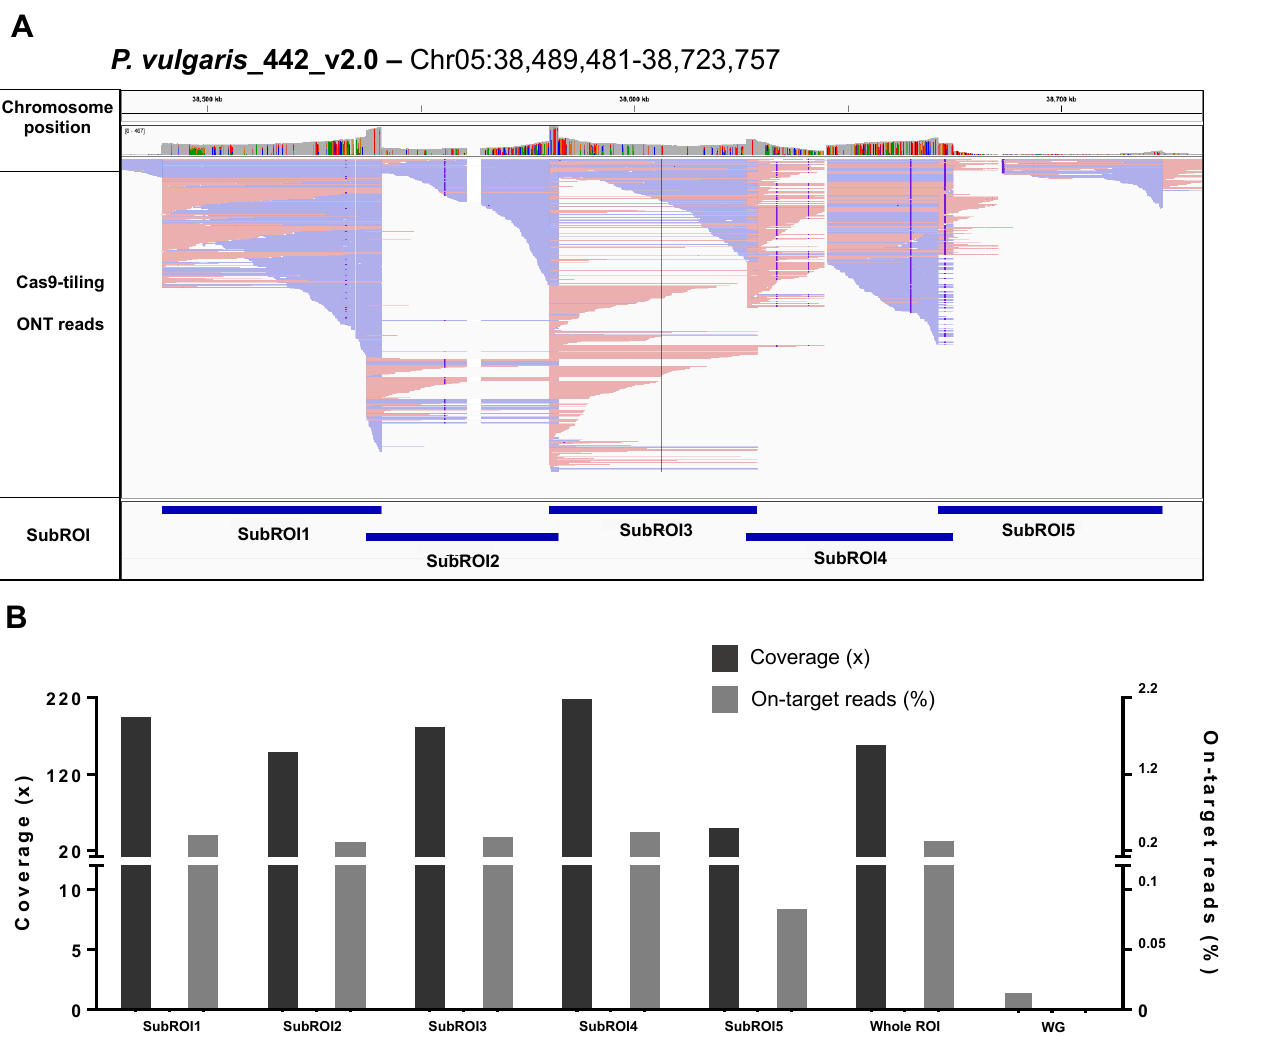
Figure 2. Sequencing of the pod-shattering region by combining Cas9 tiling with ONT sequencing. ( A ) Integrative Genome Browser Visualization (IGV) of ONT data mapping to the pod-shattering re- gion (Chr05:38,489,481–38,723,757) after Cas9 tiling and ONT sequencing of Midas DNA. ( B ) Fraction of ONT reads and average coverage on each sub-ROI, the whole ROI, and whole genome (WG) after Cas9 tiling and ONT